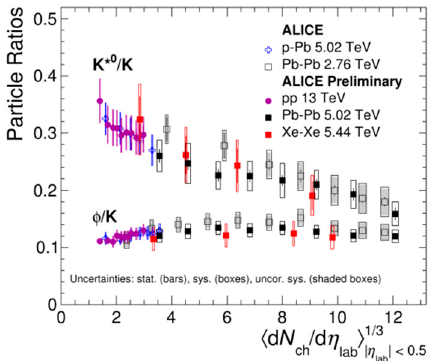
Figure 5. Ratios of p T -integrated particle yields K*(892) 0 /K and ϕ (1020)/K as a function of < dN ch / d η > 1/3 for different collision systems and energies. The statistical uncertainties are shown as bars. Boxes show systematic uncertainties. The shaded boxes are the multiplicity uncorrelated systematic uncertainties.